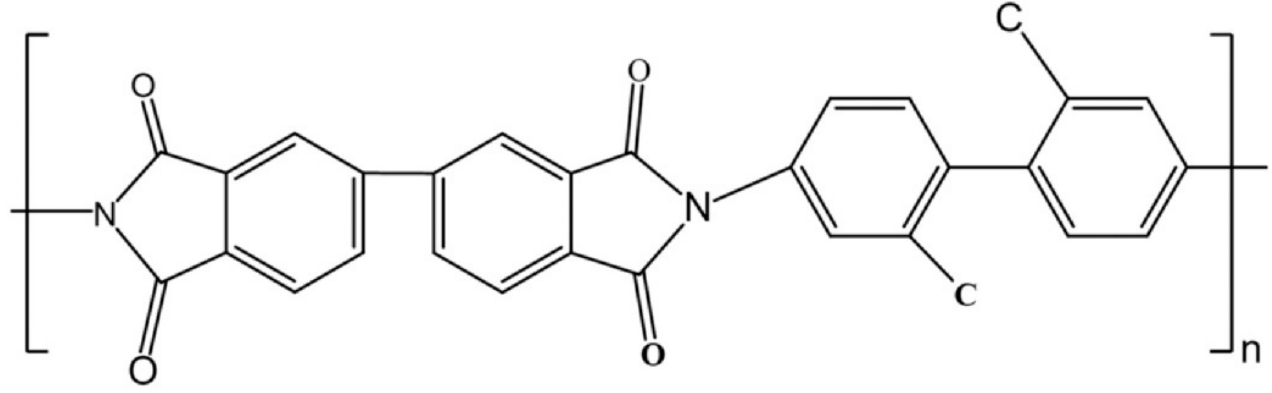
Figure 1. The chemical structure of the repeating unit of the PI aerogel.